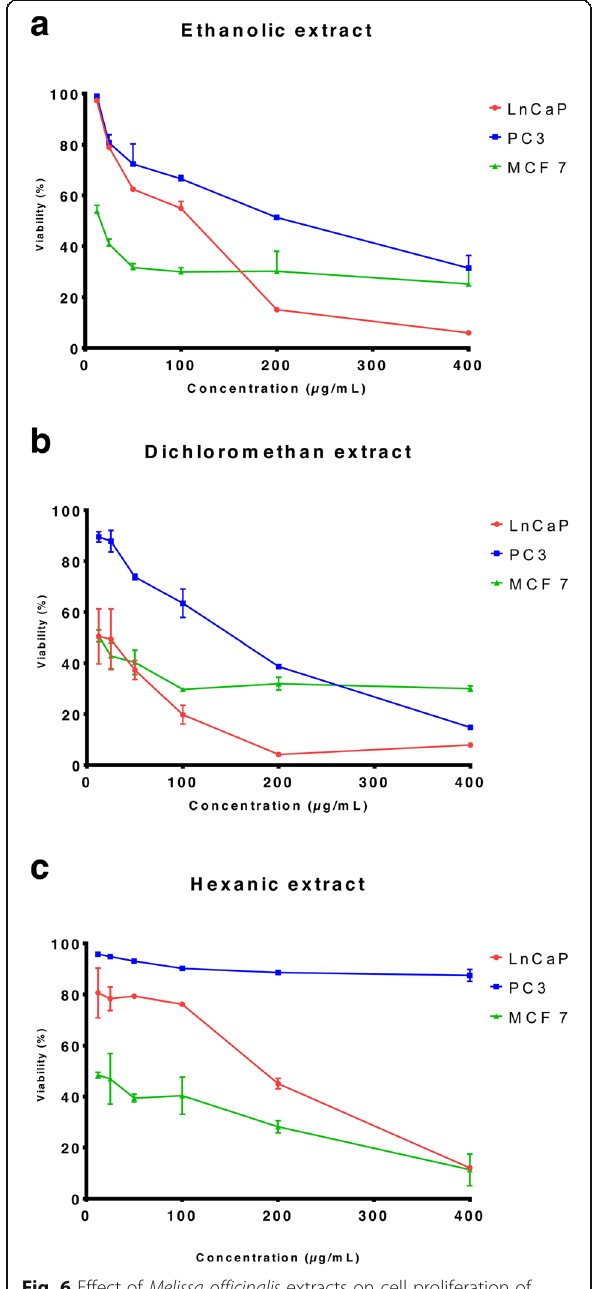
Fig. 6 Effect of Melissa officinalis extracts on cell proliferation of MCF7, LNCAP, and PC3 cell lines, presented as a percentage of cell viability, versus concentration of the extracts. Dichloromethane ( a ) ethanol ( b ) and n -hexane ( c ) extracts with increasing concentrations in the range 12.5 to 400 μ g/mL for each extract. Data represent means ± SEM of experiments performed in duplicate. Untreated cells were used as negative control and mitomycin C was used as positive against MCF7 cells. Of the prostate cancer cell lines, of the extracts compared to PC3.